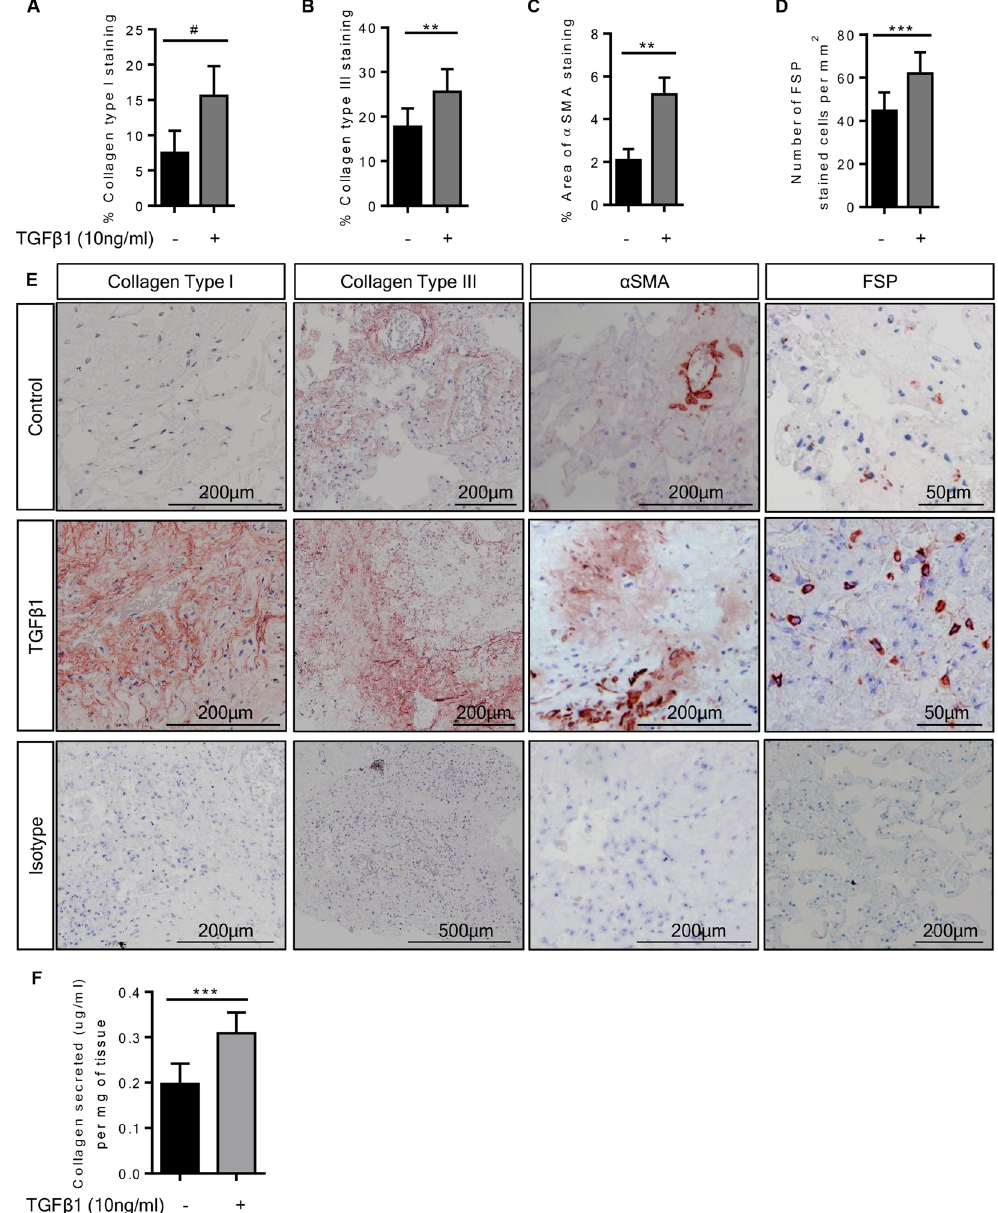
Figure 3. Immunohistochemical analysis of TGF β 1-stimulated tissue compared to matched control tissue. ( A ) The percentage collagen type I staining in TGF β 1 (10 ng/ml)-stimulated tissue was significantly greater than in control tissue following 7 days of ex vivo culture, P = 0.0002, n = 13. ( B) Similarly, collagen type III staining was increased in TGF β 1-stimulated tissue, as measured by percentage area stained, P = 0.0017, n = 13. ( C ) α SMA staining was significantly higher in TGF β 1-stimulated tissue, P = 0.0012, n = 13. ( D) The number of fibroblast- like cells assessed by counting cells stained with FSP antibody was increased following 7 days of TGF β 1- stimulation in comparison to control tissue, P = 0.0006, n = 13. ( E ) Representative immunohistochemical staining is depicted for each antibody for both control and TGF β 1-stimulated tissue following 7 days of ex vivo culture, including representative images of relevant isotype controls. ( F) Supernatants following 4 days of ex vivo culture were analysed for collagens type I to V using the Sircol dye base method. The amount of collagen secreted ( µ g/ml) was assessed per total weight of tissue present in the well (mg). Collagen was significantly increased in supernatants from TGF β 1-stimulated tissue in comparison to non-stimulated tissue following 4 days of ex vivo culture, P < 0.0001, n = 15. Data are presented as median ± IQR, #P < 0.05, (Wilcoxon matched pairs signed rank test), or mean ± SEM ** P < 0.01, *** P < 0.001 (paired t The selective K 3.1 blocker Senicapoc (ICA-17043) attenuates TGF β 1-dependent fibrogenesis Ca in human lung parenchyma. We predict that studying fibrogenesis in human tissue may prove effective for identifying drugs that have efficacy in IPF. K Ca 3.1 channels are a promising therapeutic target. Consistent